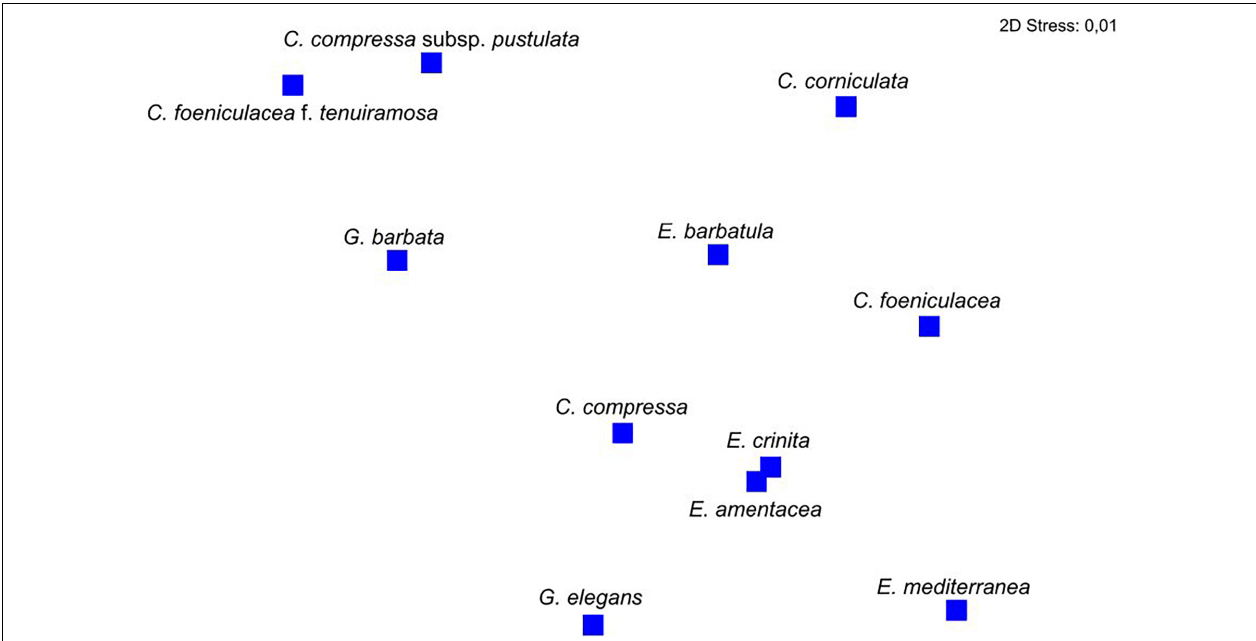
FIGURE 6 | Non-metric multidimensional scaling (nMDS) analysis plot based on Bray-Curtis Index values showing the relationship at 10 m transects between the eleven fucalean species and subspecific taxa studied. C, Cystoseira ; E, Ericaria ; G, Gongolaria .